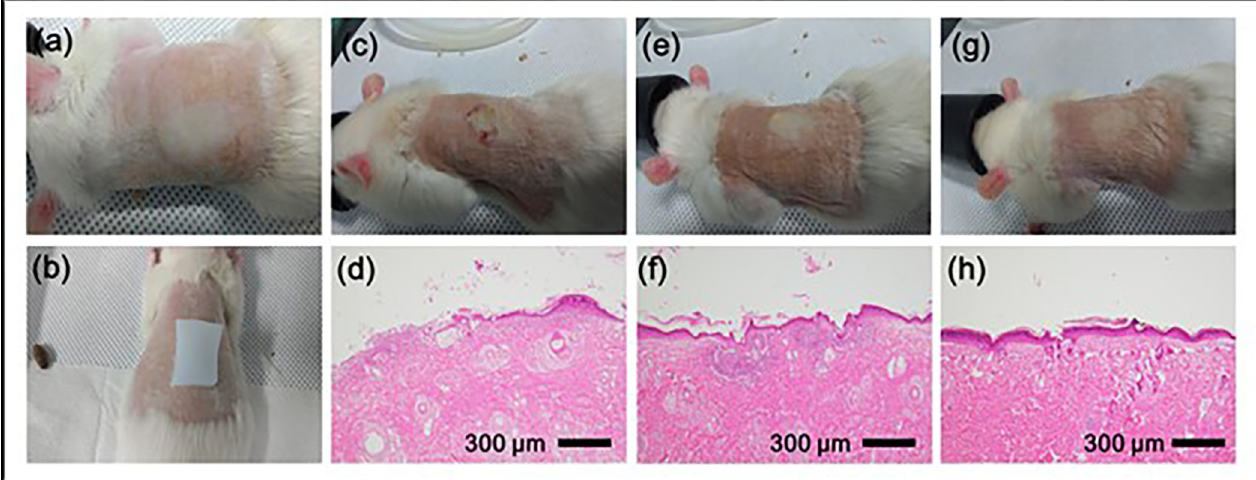
Fig 4. Rat model of wound healing. The back skin of the rats was exposed to a third-degree burn using an iron (dotted circle in (a)). The wound area was covered with three kinds of wound dressings: (b) sterilized water gauze (c and d), hydrogel without Melia azedarach extract (MAE) (e and f), and hydrogel with MAE (g and h). After 48 h, the wound surface was observed with the naked eye (c, e, and g), and examined histologically (d, f, and h).